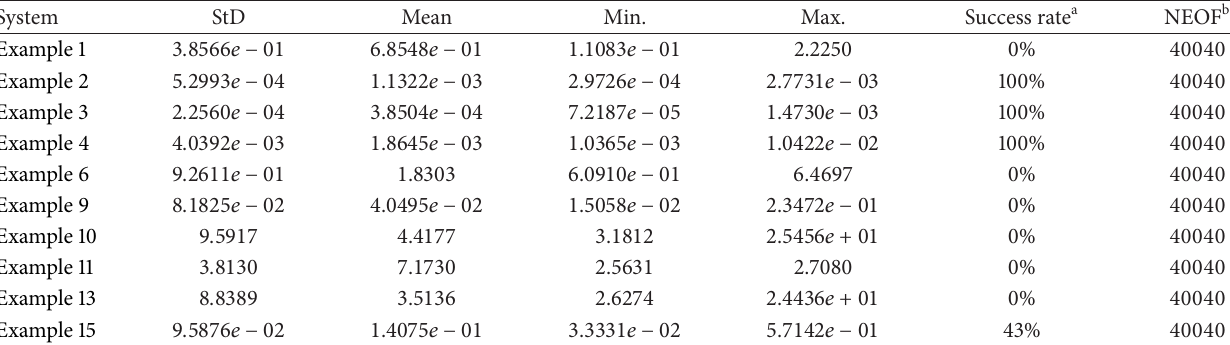
Table 3: Simulation for fractional-order systems by single cuckoo search.